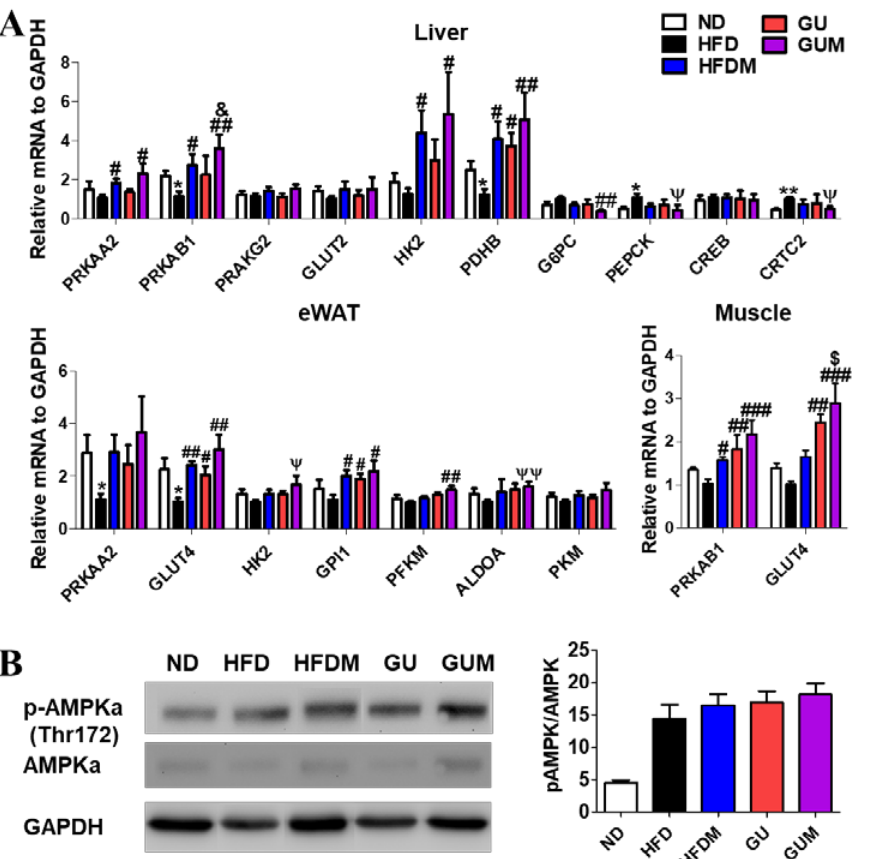
Figure 6. Effect of metformin, G. uralensis Fischer, and their combination after 16 weeks on AMPK- mediated glucose metabolism-related gene ( A ); and protein ( B ); expression in C57BL/6J mice fed a high-fat diet (HFD). Data are presented as the mean ± SEM. Significant differences between HFD and ND are indicated: * p < 0.5, ** p < 0.01. Significant differences among the high-fat diet-fed groups are indicated: # p < 0.05, ## p < 0.01, ### p < 0.001. Significant differences between GUM and HFDM are indicated: $ p < 0.05. Significant differences between GUM and GU are indicated: & p < 0.05. When compared one-to-one, there were significant differences between GUM and HFD groups ( Ψ p < 0.05, ΨΨ p < 0.01). ND, normal diet (AIN-93G 16 kcal% fat); HFD, high-fat diet (60 kcal% fat); HFDM, HFD + metformin 50 mg/kg; GU ( G. uralensis Fischer), HFD + GU 0.015%; GUM, HFD + GU 0.015% + metformin 50 mg/kg .